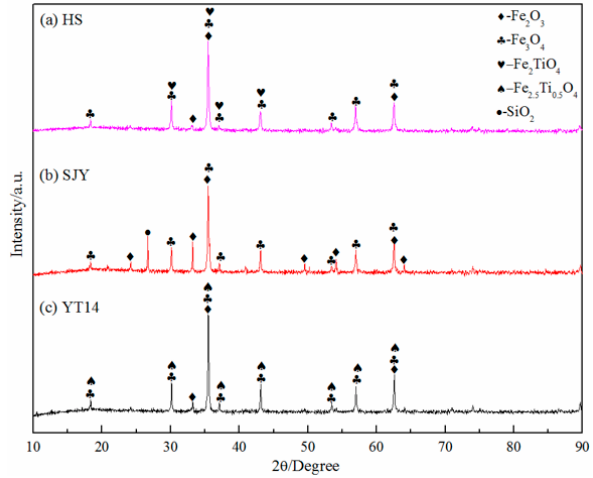
Figure 1. X-ray diffraction analysis pattern of experimental raw materials.